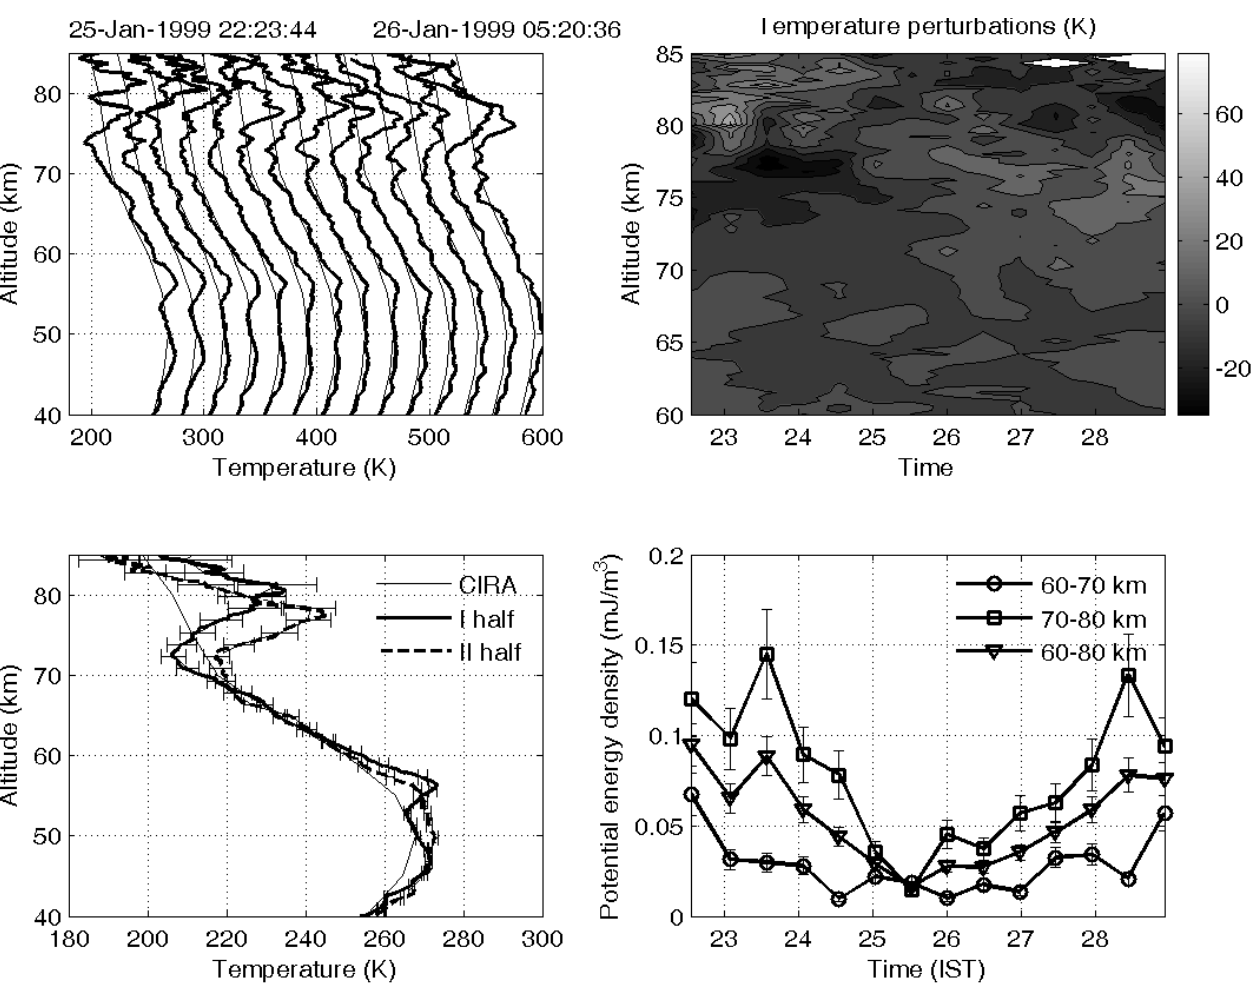
Fig. 2. Same as Fig. 1 except that it is for 25–26 January